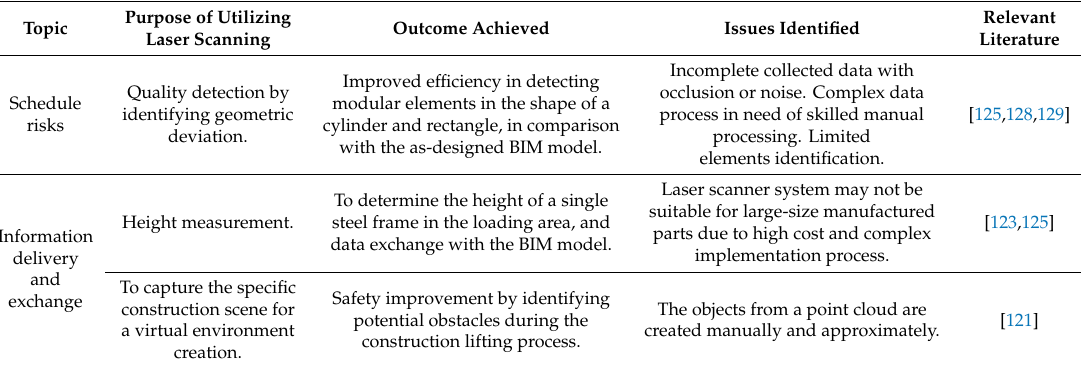
Table 13. Research topics, purpose of laser scanning adoption, and outcomes achieved in previous studies.